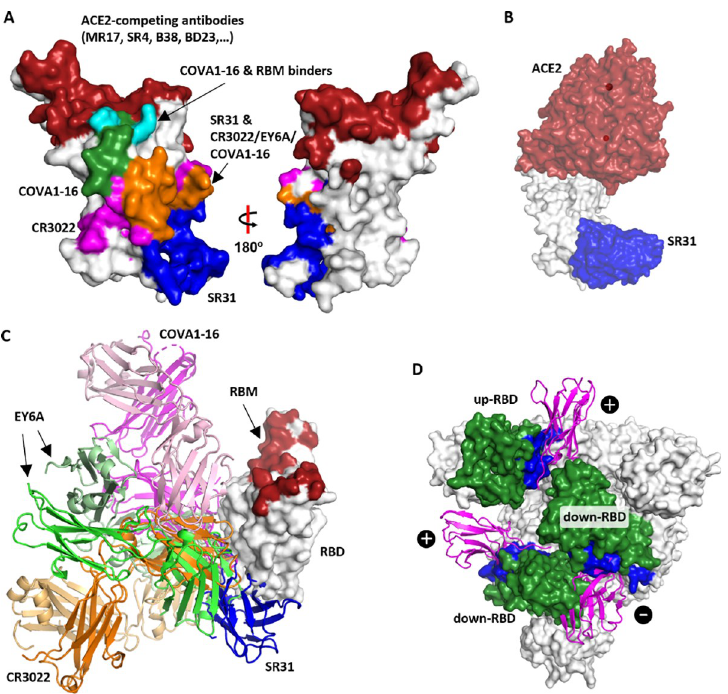
Fig 3. SR31 engages RBD at a site distal to the receptor-binding motif. ( A ) Comparison of the SR31 epitope with epitopes for other RBD-targeting nanobodies [22, 35, 36, 39] and mAbs [13–15,19, 20, 23, 24, 26–28]. Red, the collective epitope of RBM-binders; blue, the SR31 epitope; magenta, the collective epitope of CR3022 and EY6A; green, the COVA1-16 epitope; cyan, the overlap between the epitopes of the RBM binders and COVA1-16; orange, the overlap between the CR3022/EY6A/COVA1-16 and SR31 epitope. ( B ) SR31 (blue) binds to RBD (grey) at a surface distal to the binding site of ACE2 (red). ( C ) Comparison of the binding mode between SR31 (blue) and three mAbs including CR3022 (orange and wheat), EY6A (green and pale green), and COVA1-16 (pink and magenta). RBD is shown as white surface with RBM highlighted in red. ( D ) The binding site of SR31 in the context of the S trimer at its pre-fusion ‘open’ state with one RBD in the ‘up’ conformation and two in the ‘down’ conformation. The structure (PDB ID 6yvb) [3] is viewed from the ‘top’ (perpendicular to the viral membrane). The SR31 epitope is shown in blue. The three RBDs are colored green. SR31 (magenta cartoon) is aligned to the S trimer (surface presentation) by superposing the SR31-RBD structure to each of the RBD. ‘+’, no or minor clashes; ‘-’, with severe clashes.